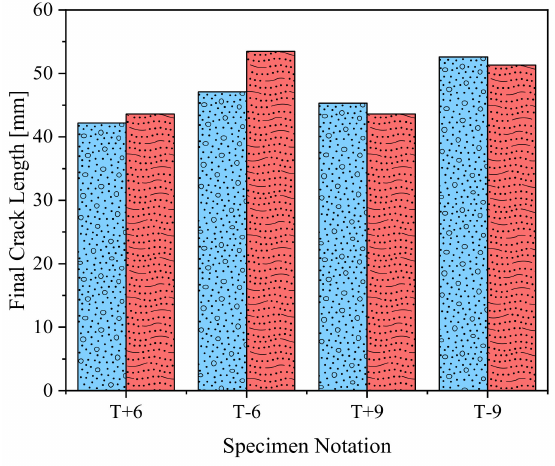
Figure 31. Measurement results of a specimen after an explosion: final crack length [146].